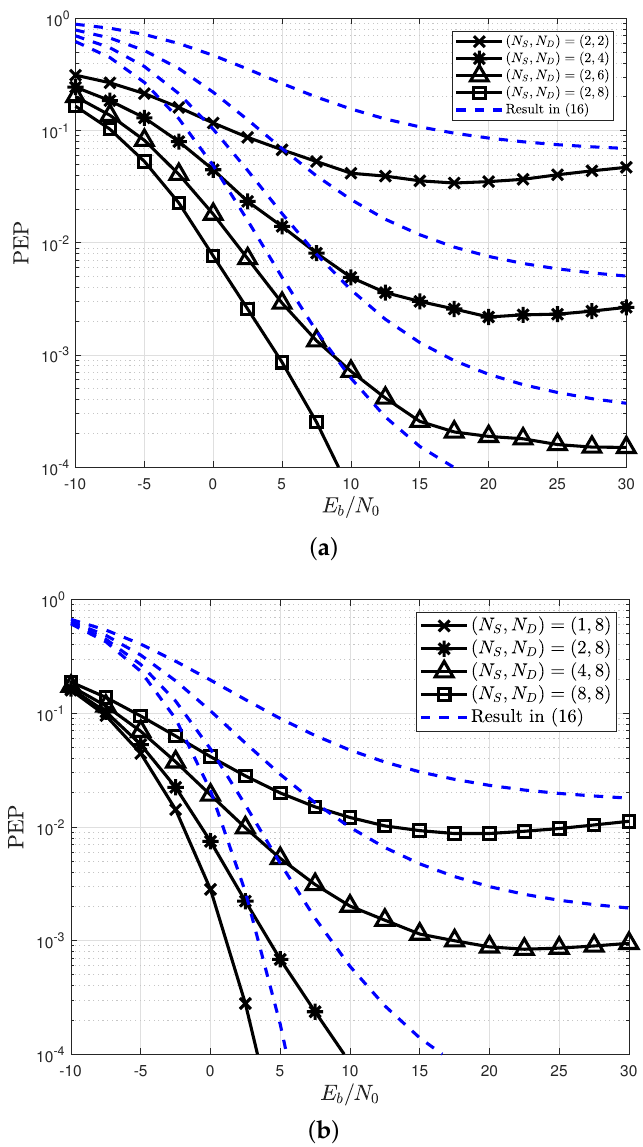
Figure 3. Verification of the weighted Hamming distance for the PEP in Lemma 1. ( a ) Different number of N D ; ( b ) different number of N S